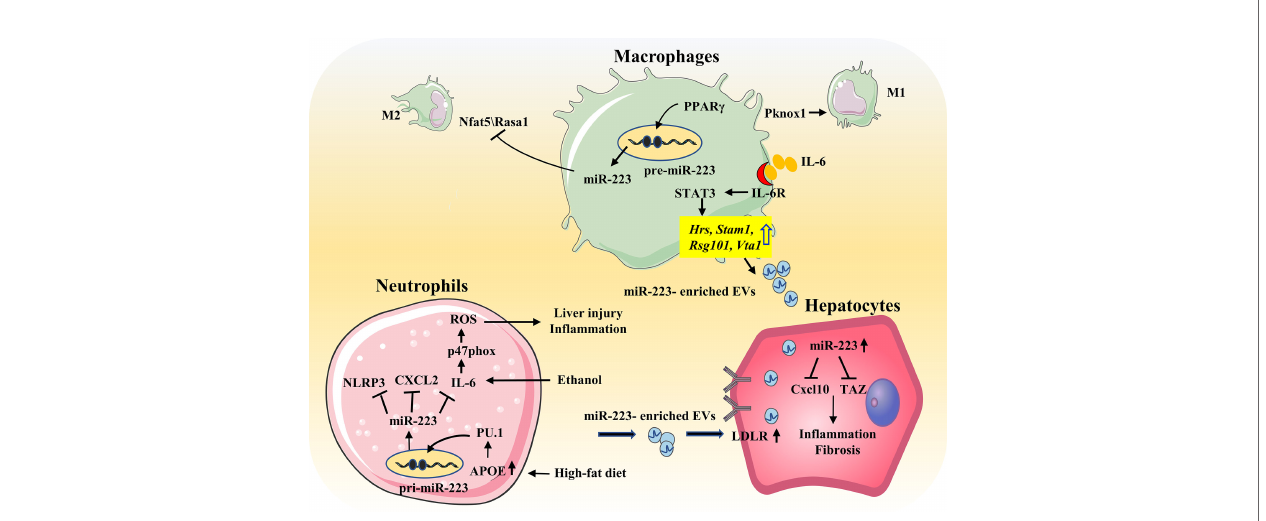
FIGURE 4 | Role of miR-223 in the progression of NAFLD and ALD. During HFD, free fatty acids elevate miR-223 expression in neutrophils by regulating APOE/PU.1 signaling. MiR-223 directly targets NLRP3, CXCL2, IL-6 to ameliorate in fl ammatory responses. And miR-223 can also form a feedback loop to prevent NASH progression by promoting the preferential uptake of neutrophil-derived miR-223/APOE-enriched EVs in hepatocytes. IL-6 signaling promotes macrophages to release miR-223- enriched exosomes that inhibit expression of several miR-223-targeted genes in hepatocytes, thereby attenuating NASH-associated liver fi brosis. In addition, PPAR g / miR-223 axis control macrophage polarization and protects against diet-induced adipose tissue in fl ammatory response and systemic insulin resistance. PPAR g can enhance miR-223 expression by directly binding to pre-miR-223 promoter. MiR-223 is required for PPAR g -induced M2 macrophage polarization by controlling expression of the target genes Nfat5 and Rasa1. Moreover, miR-223 inhibits Pknox1 expression, thereby suppressing proin fl ammatory activation of M1 response. Ethanol elevates miR-223 levels. MiR-223 attenuates neutrophil function by inhibiting the IL-6 – p47phox – ROS pathway, thereby protecting against